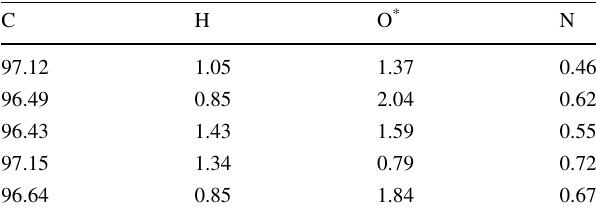
Table 1 Elemental analysis of activated coke samples (wt%, daf)